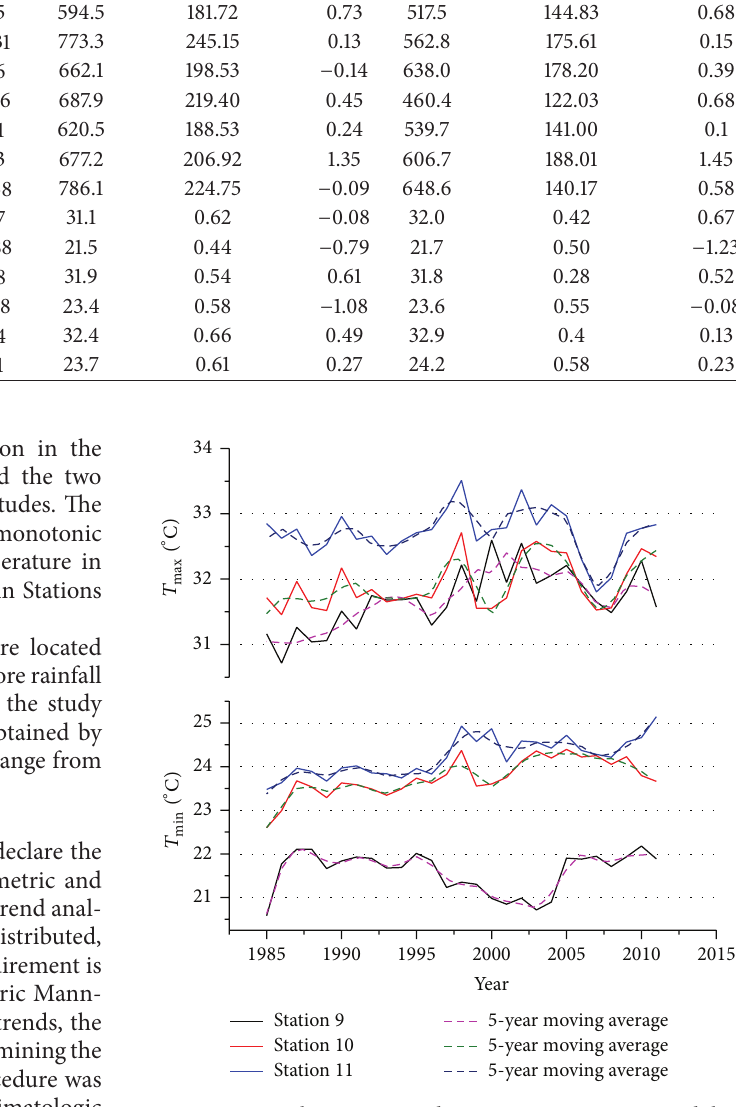
Figure 2: Annual maximum and minimum temperatures and their 5-year moving average in the Langat River